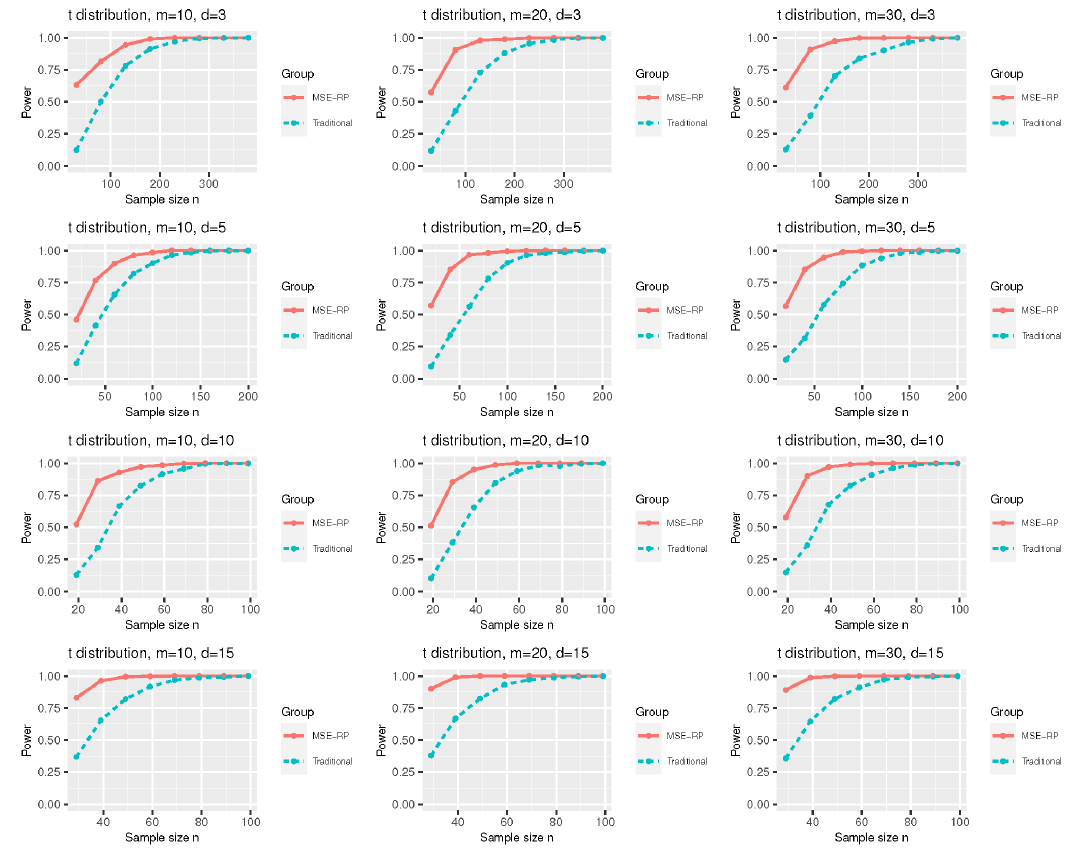
Figure 1. Power ( α = 0.05) in multivariate t